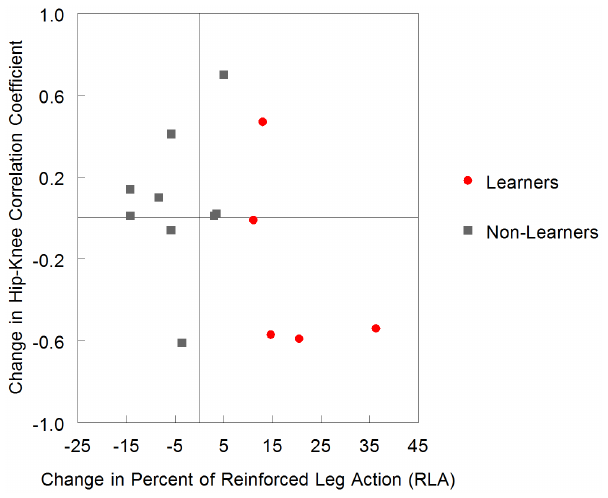
Figure 10. Scatterplot of change in percent of reinforced leg action by change in hip-knee correlation coefficient. Difference in percent of reinforced leg action (RLA) between Day 2 acquisition condition and Day 1 baseline (learning criteria) by difference in hip-knee correlation coefficient between Day 2 acquisition condition and Day 1